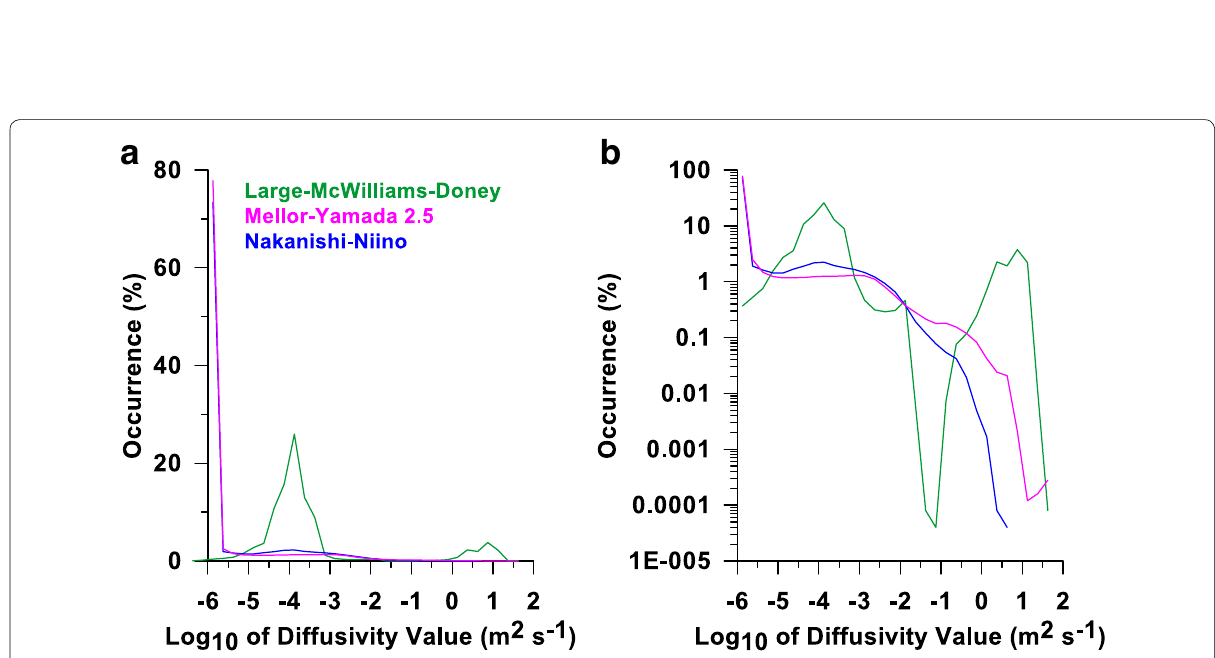
Fig. 8 Probability density distributions of the vertical temperature diffusivities along a North–South transect over the guyot. The values for LMD are given in green, MY in magenta, and NN in